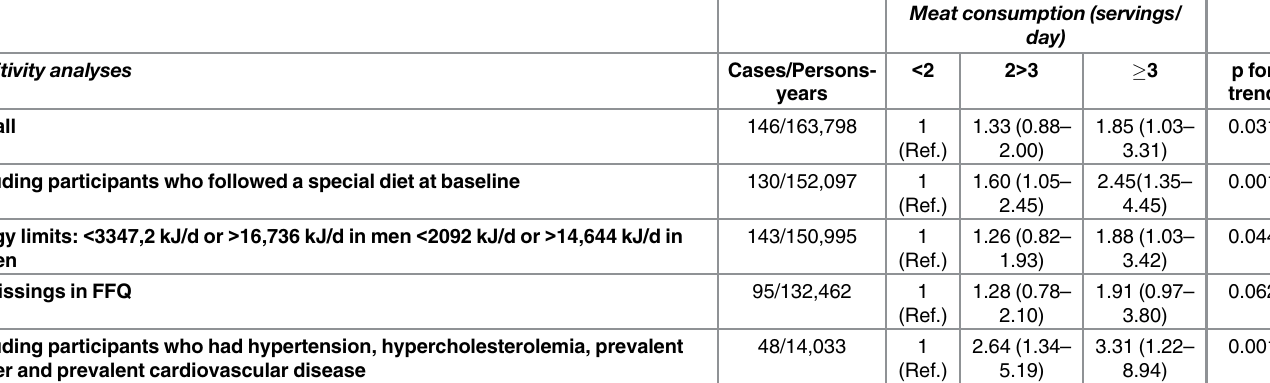
Table 4. Sensitivity analyses: HR and 95% CI for incident type 2 diabetes according to categories of daily meat consumption. The SUN Project 1999 –